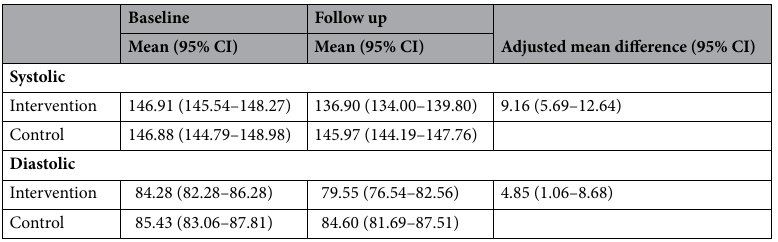
Table 2. Mean difference in blood pressure treatment. Complete case analysis. N = 84 (n = 50 intervention, n = 34 control) for the follow up. Data present mean difference in reduction of blood pressure between intervention and control group at 3 months, adjusted for baseline values.